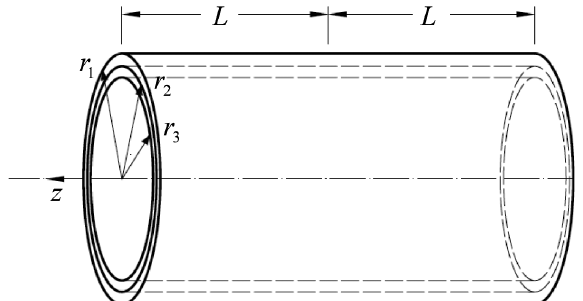
Fig. 11. Composite cylinder under internal pressure.